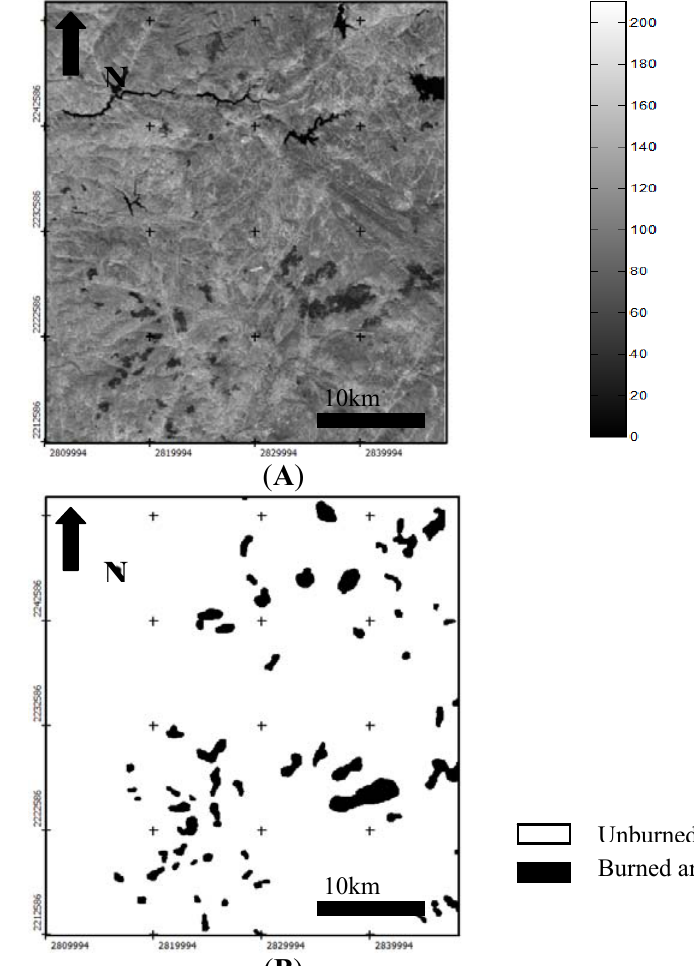
Figure 6. Snapshots in North-west Spain (ETRS89/LAEA projection) corresponding to: ( A ) Near infrared IRS-AWiFS; ( B ) EFFIS-RDA burned scar; ( C ) IRS-AWiFS-based burned